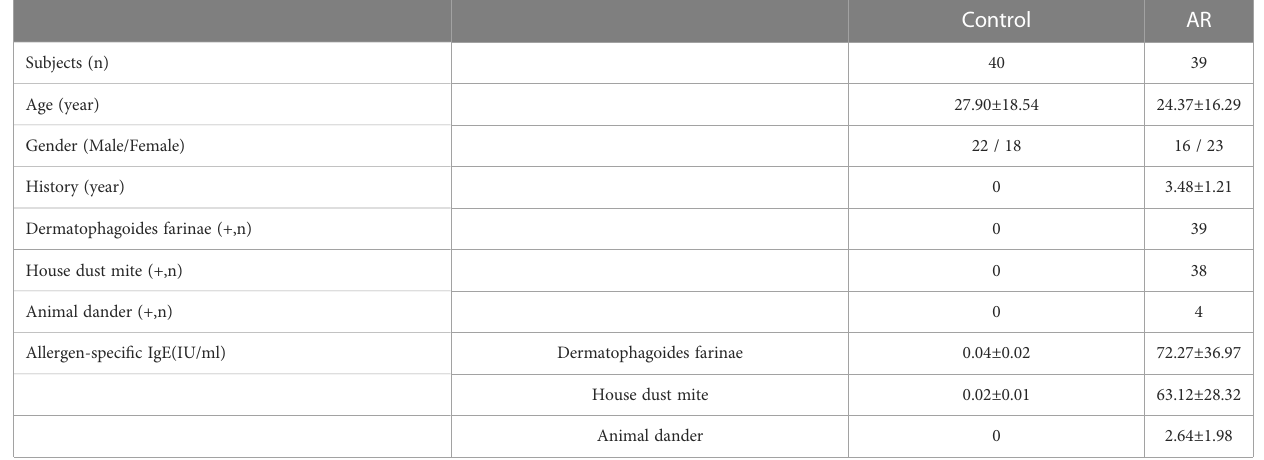
TABLE 1 Clinical characteristics of enrolled